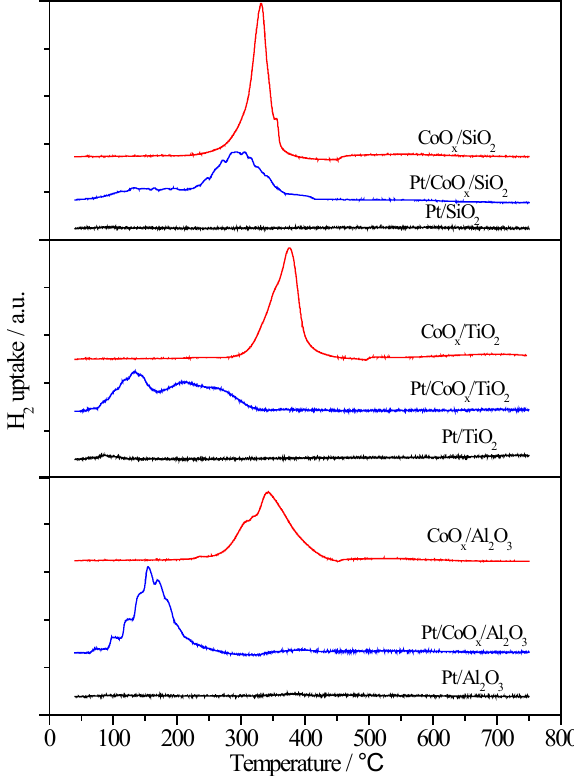
Figure 11. H 2 -TPR profiles of SiO 2 , TiO 2 , and Al 2 O 3 -based